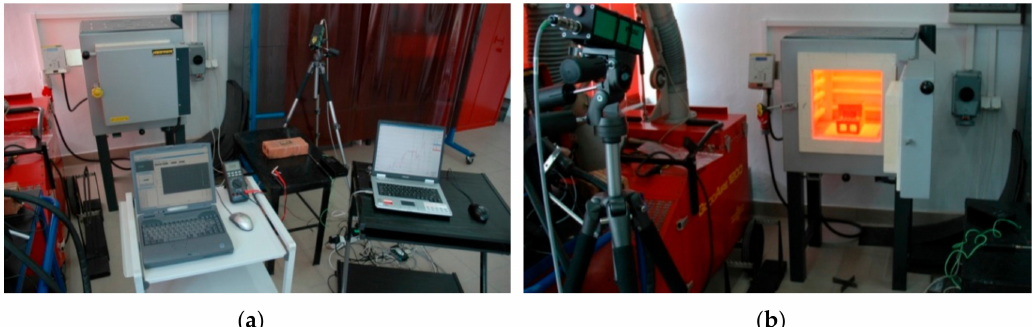
Figure 5. A view of experimental setup: ( a ) with an electronically controlled furnace and high temperature pyrometer IMPAC IS 140; ( b ) a view of temperature measurements on the surface titanium alloy sample in a high temperature range.